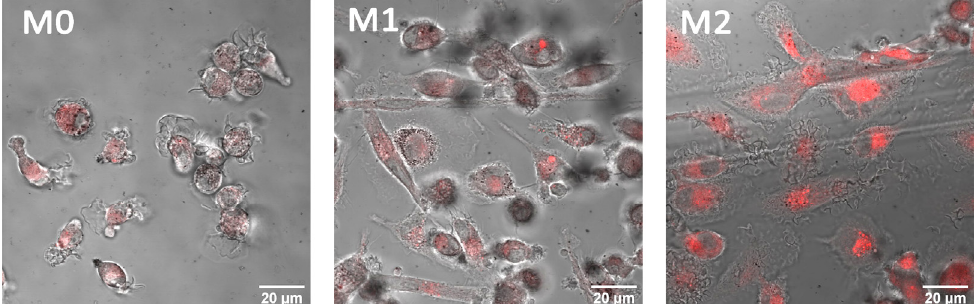
Figure 5. Fluorescence images of M0, M1 and M2 macrophages after 24 h of incubation with AlPc NP colloids. AlPc NP fluorescence is red.